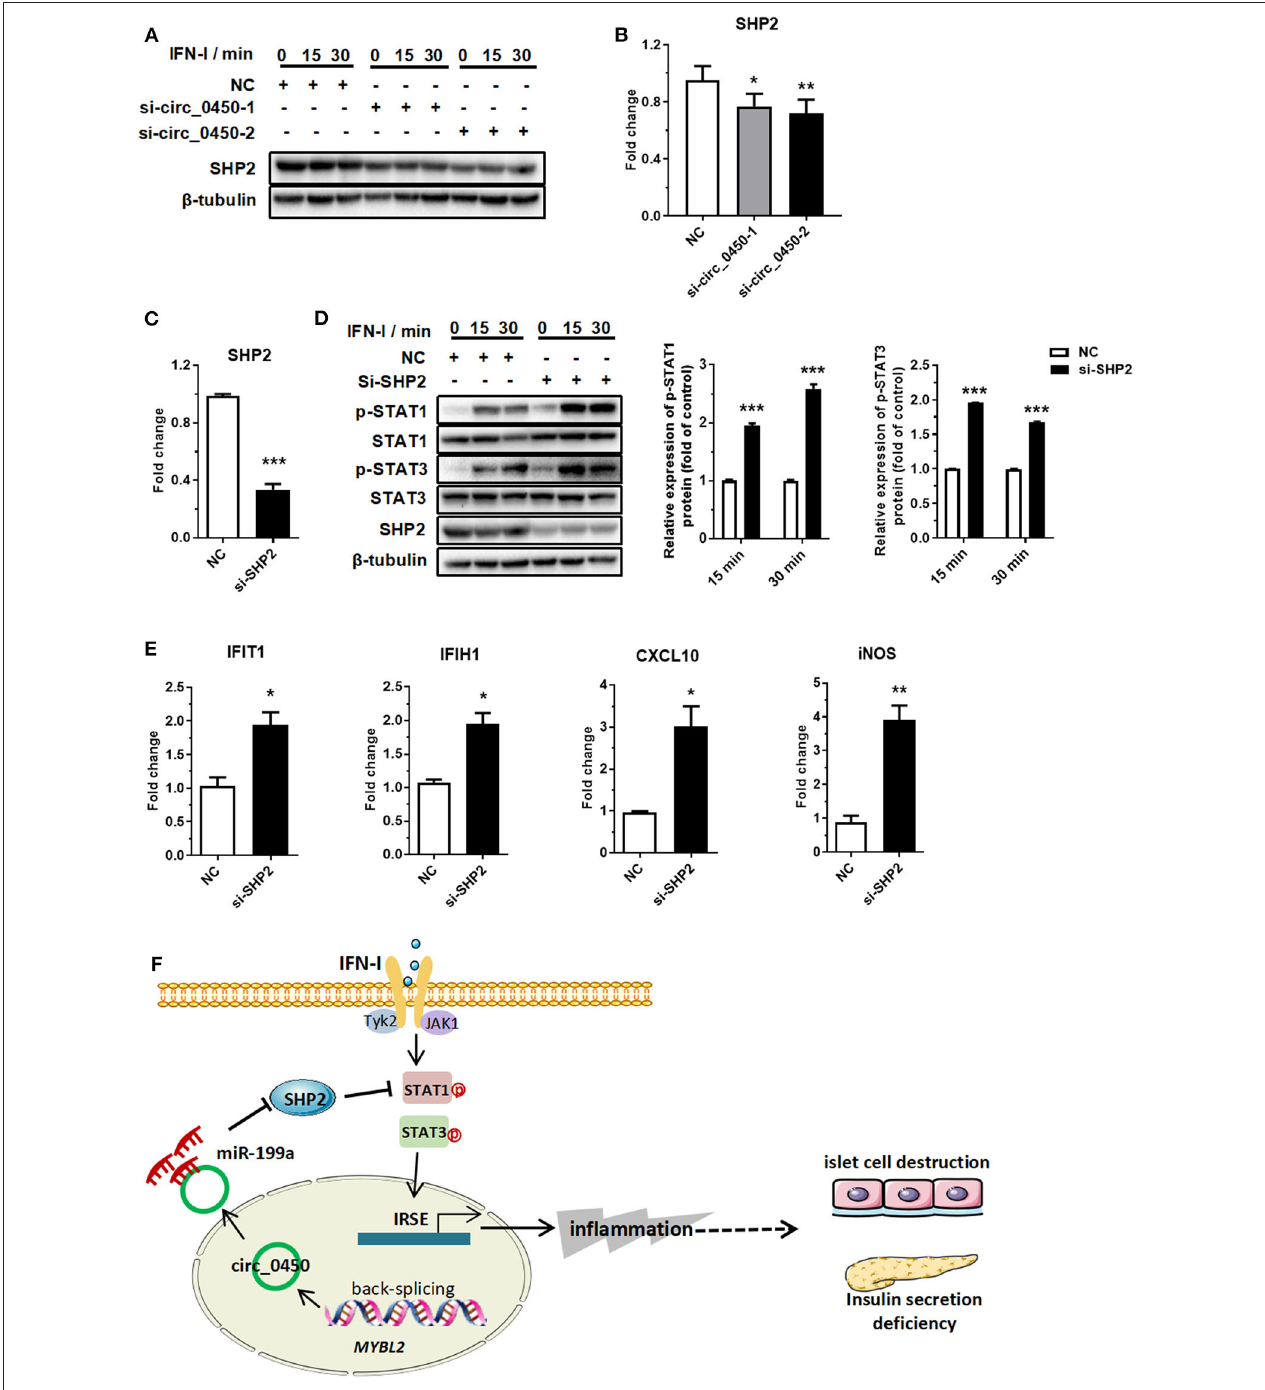
FIGURE 5 | Hsa_circ_0060450 upregulates SHP2 by adsorbing miR-199a-5p. (A) SHP2 protein assessment at 0, 15, and 30min of IFN-I stimulation after treatment with two hsa_circ_0060450 siRNAs. (B) RT-qPCR analyses of SHP2 expression after treatment with two hsa_circ_0060450 siRNAs. (C) RT-qPCR analysis of SHP2 expression to confirm the silencing efficiency of the SHP2 siRNA. (D) STAT1 and STAT3 phosphorylation level assessment at 15 and 30min of IFN-I stimulation after treatment with the SHP2 siRNA. (E) RT-qPCR analyses of IFIT1 , IFIH1 , CXCL10, and iNOS under IFN-I stimulation after treatment with the SHP2 siRNA. (F) A schematic model of the function of hsa_circ_0060450 in IFN-I-stimulated macrophages and in T1DM. NC, negative control. Data represent means ± SEM. * p < 0.05, ** p < 0.01, *** p < 0.001.